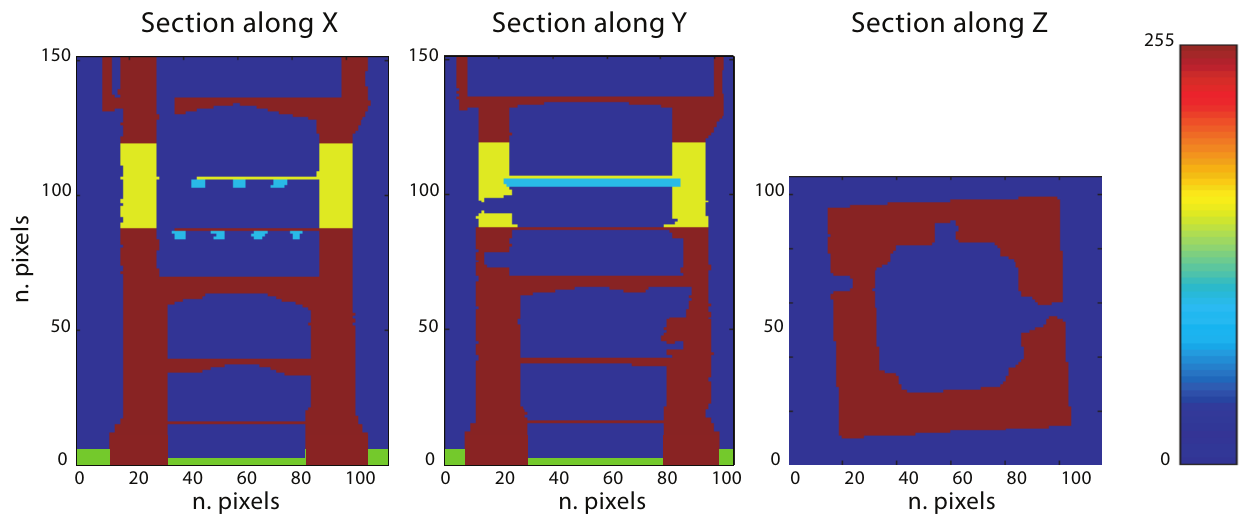
Figure 11. Visualization of the three-dimensional material matrix: voxels possess unitary